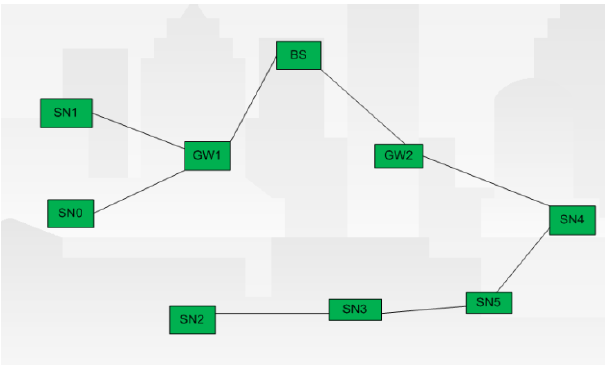
Figure. 2 Sparse topology sensor network